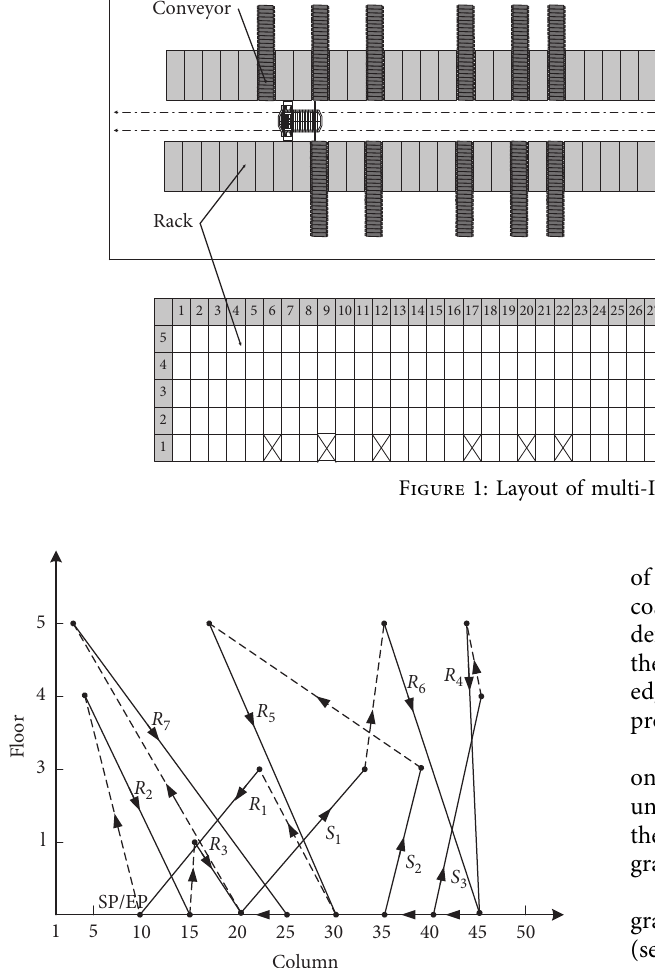
Figure 2: Stacker movement route with three storage requests and seven retrieval requests: the horizontal axis and the vertical axis represent the column and floor, where the stacker access point is located, respectively, the solid line represents load travel, and the dotted line represents no-load